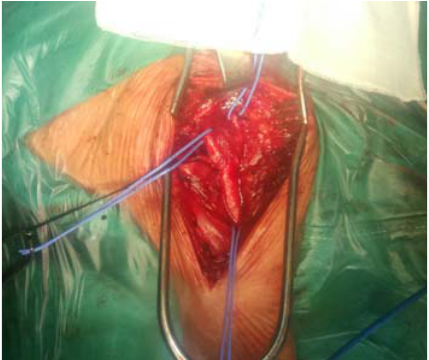
Figure 1: Intraoperative image showing a carotid artery bifurcation and a type II carotid body tumor.